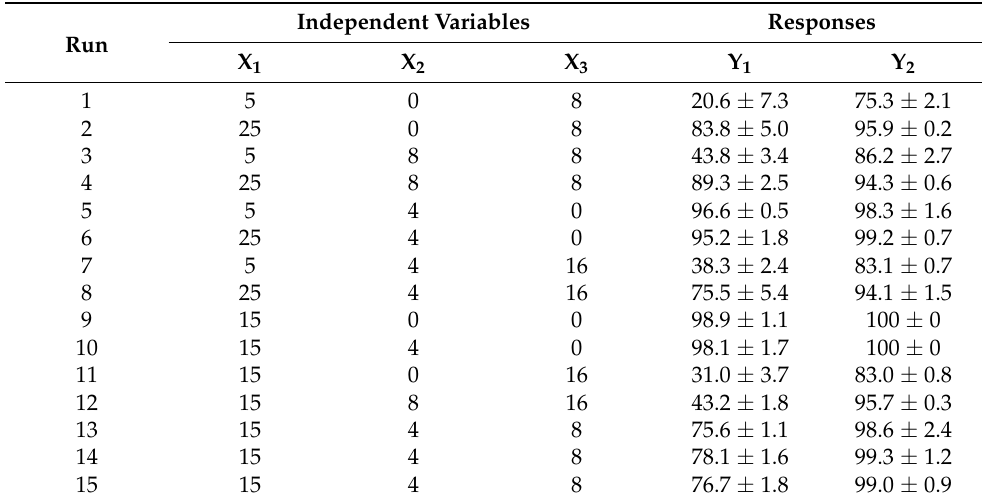
Table 2. Results for the experimental points created according to the BBD. The last three points were marked as central for the experimental space.